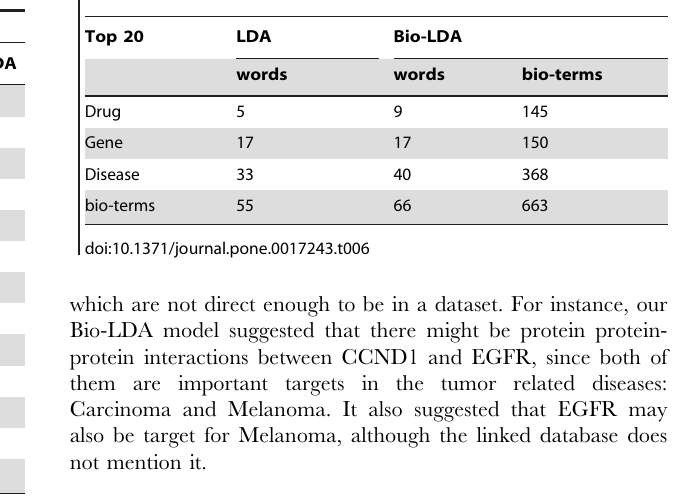
Table 4. a) Frequency word sets of LDA model and Bio-LDA model. b) Mappings between Bio-LDA model and LDA model.